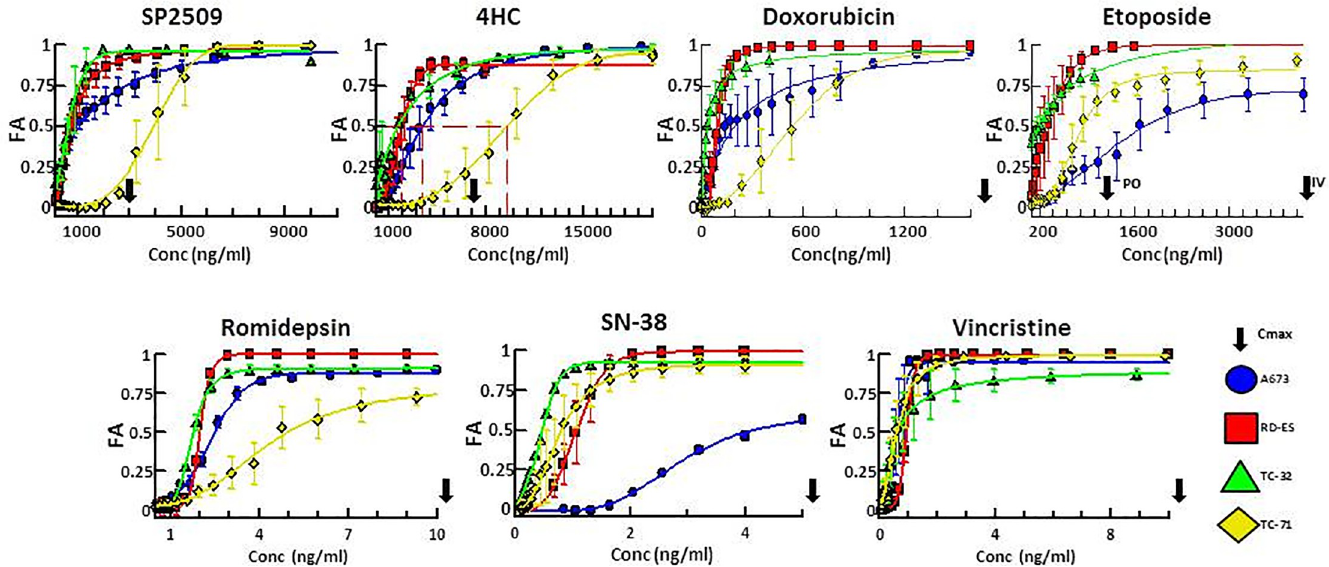
Fig 1. Single agent dose response plots for 7 tested agents against 4 ES cell lines demonstrate efficacy at clinically achievable concentrations. Dose response plots of each drug tested across 4 cell lines plotted as fraction affected (FA) versus concentration (ng/ml). Data was recovered 72 hours after drug treatment. Plotted points represent the mean FA values while error bars represent ± SEM (standard error of the mean) between technical replicates. Arrows beyond the x-axis indicate a Cmax in excess of the values displayed.